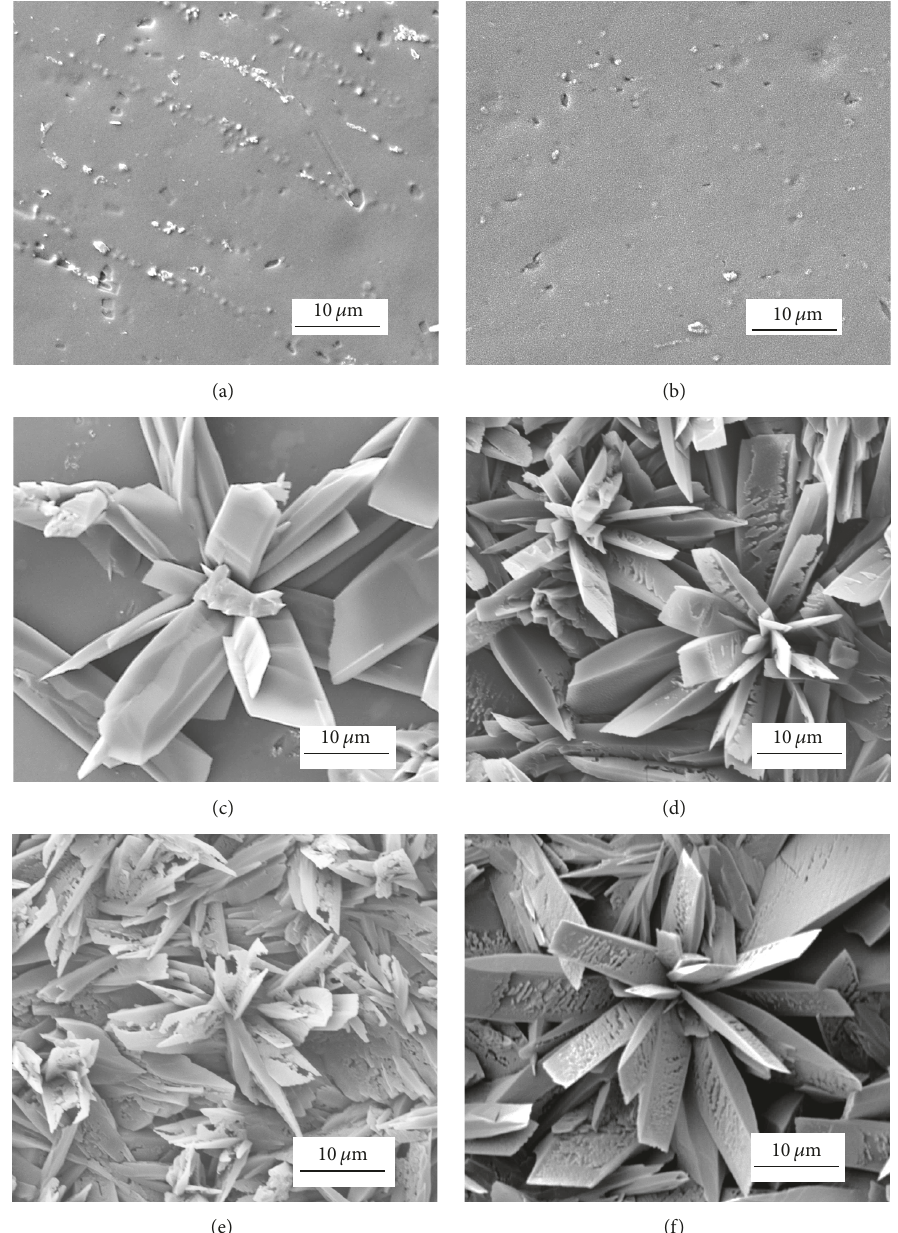
Figure 5: SEM images of as-prepared one-step APA sample (a) and samples treated at 100 ∘ C for 10min in HQ solutions of different concentrations: 1mM (b), 3 mM (c), 5 mM (d), 7mM (e), and 10mM